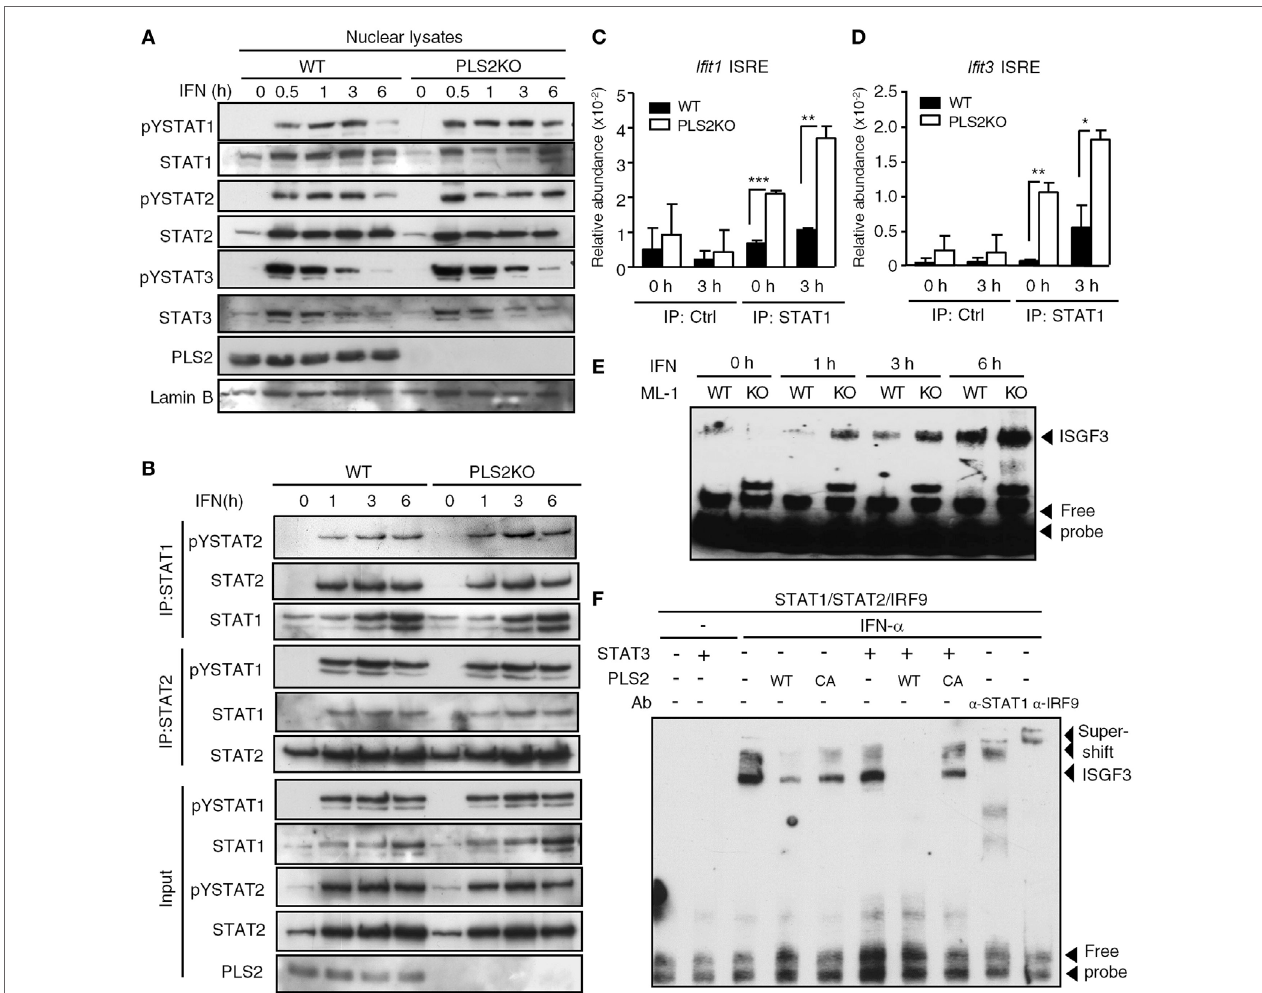
FigUre 6 | Phospholipid scramblase 2 (PLSCR2) suppresses the recruitment of ISGF3 to IFN-stimulated gene (ISG) promoters. (a) WT and PLS2KO ML-1 cells were treated with IFN- α 4 for the indicated times. Nuclear extracts were subjected to immunoblotting with antibodies against pYSTAT1, STAT1, pYSTAT2, STAT2, pYSTAT3, STAT3, PLSCR2, or lamin B. Blots are representative of three independent experiments. (B) Same as in panel (a) , except nuclear extracts were subjected to co-IP using antibodies against STAT1 or STAT2, followed by immunoblotting with antibody to pYSTAT2 or pYSTAT1, STAT2, and STAT1. Total cell extracts were subjected to immunoblotting using the indicated antibodies for input control. Blots are representative of two independent experiments. (c,D) WT and PLS2KO ML-1 cells were treated with IFN- α 4 for 3 h, followed by chromatin immunoprecipitation with antibody to control Ig (Ctrl) or STAT1 and then subjected to Q-PCR using primers to ISRE of the promoter of Ifit1 (c) or Ifit3 (D) . Relative abundance was normalized to input ( N = 3). (e) WT and PLS2KO ML-1 cells were stimulated with or without IFN- α 4 for the indicated times. Nuclear extracts of the treated cells were subjected to electrophoretic mobility shift assay (EMSA) as described in Section “Materials and Methods.” Blots are representative of two independent experiments. (F) HEK293T cells were transfected individually with empty vector (EV), HA-tagged STAT3, myc-tagged WT or CA mutant of PLS2 or cotransfected with human STAT1, STAT2, and IRF9 for 48 h and then treated with or without IFN- α 2 for 60 m. The nuclear lysates were added together in vitro as indicated before EMSA. For the supershift assay, anti-STAT1 or anti-IRF9 antibodies were added to the mixture. Blots are representative of two independent experiments. Data are shown as mean ± SD, ** p < 0.01, and *** p <